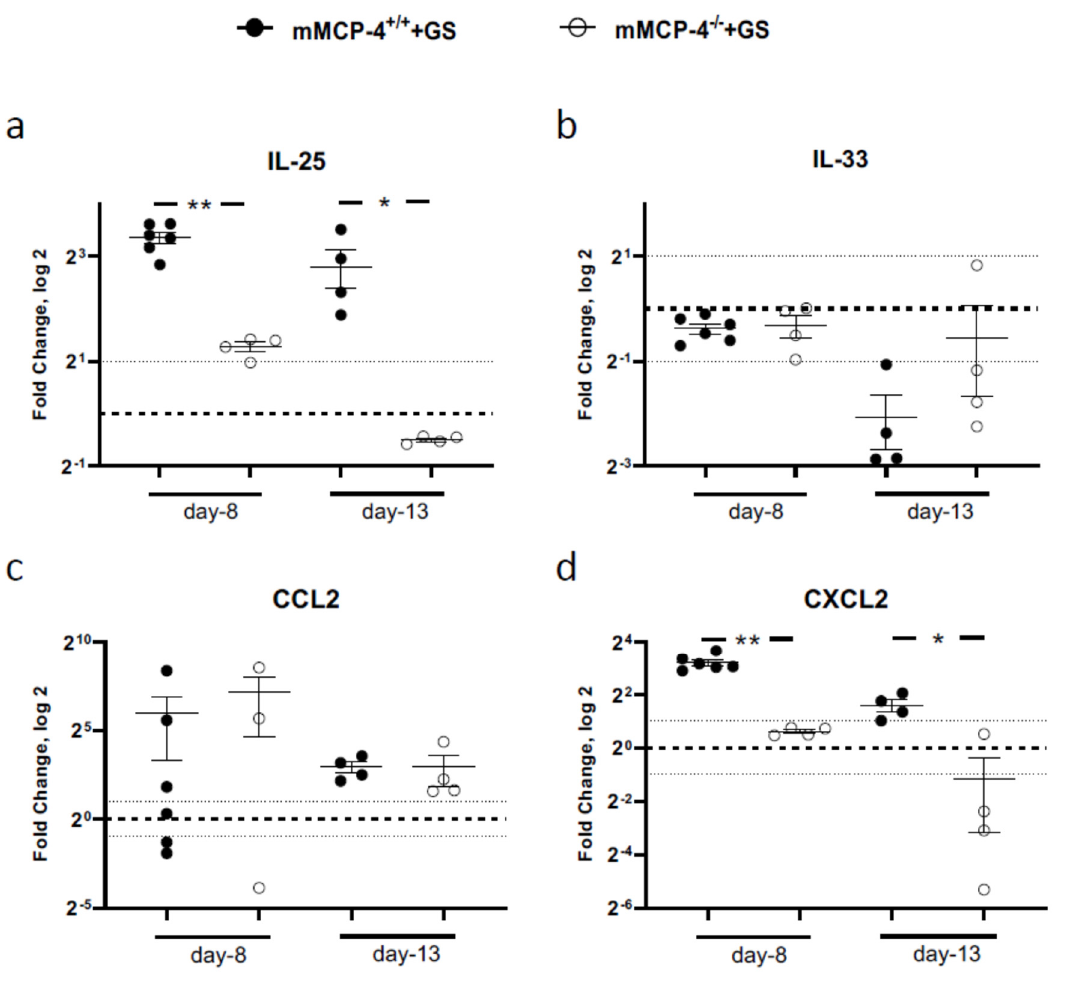
Figure 5. Alarmin and chemokine expression levels in mMCP-4 +/+ and mMCP-4 − / − mice infected with Giardia intestinalis . Intestinal expression (qPCR) 8 dpi and 13 dpi of IL-25 ( a ) and the alarmin IL-33 ( b ) as well as the chemokines CCL2 ( c ) and CXCL2 ( d ) in Giardia -infected mature adult mice from experiments #2, #3a, and #6. Fold changes were calculated after normalization to GAPDH. The dotted line is at 1 and indicates no fold change. In ( a ) and ( d ), *, ** indicate p < 0.05 or 0.01 for mMCP-4 +/+ vs. mMCP-4 − / − mice.